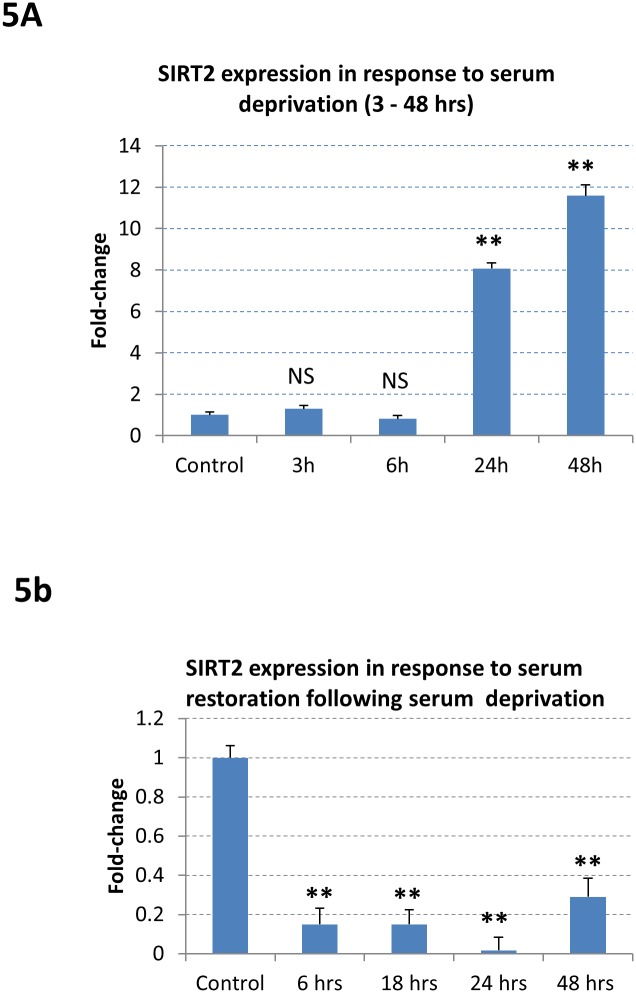
The response of SIRT2 mRNA expression to serum deprivation and serum restoration following serum deprivation.5A. The Hela cells were initially maintained in DMEM medium (glucose concentration: 4.5 g/L) containing 10% FBS. After washing with PBS twice, the cells were subjected to serum deprivation stress with DMEM containing 0.1% FBS for 3 hours, 6 hours, 24 hours and 48 hours, respectively. SIRT2 expression is increased from 24h to 48h after serum deprivation. 5B. For the treatment of serum restoration following serum starvation, the cells were first cultured in DMEM containing 0.1% serum for 48 hours, then were cultured in DMEM containing 10% serum for additional 6, 18, 24, and 48 hours, respectively. SIRT2 expression was decreased after 6 hours serum restoration (0.15+0.08, p<0.01**, n = 3), 18 hours serum restoration (0.15+0.07, p<0.01**, n = 3), 24 hours serum restoration (0.018+0.06, p<0.01**, n = 3) and 48 hours serum restoration (0.29+0.09, p<0.01**, n = 3).